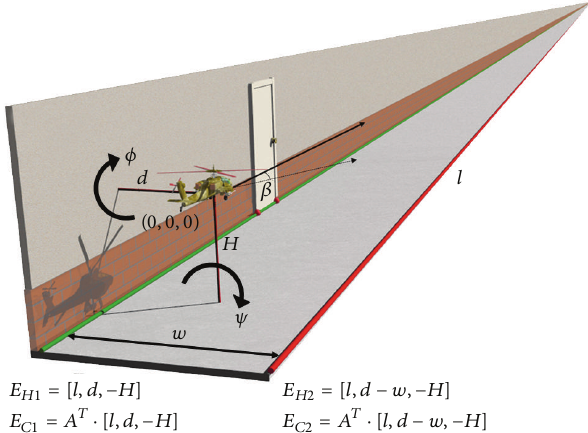
Figure 4: A visual description the environment as perceived by the infinity-point